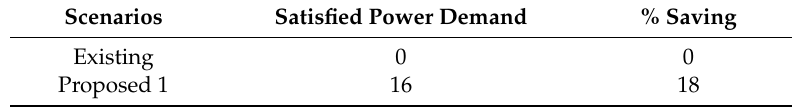
Table 3. Comparison of the proposed and existing satisfied power demand management for case-II.